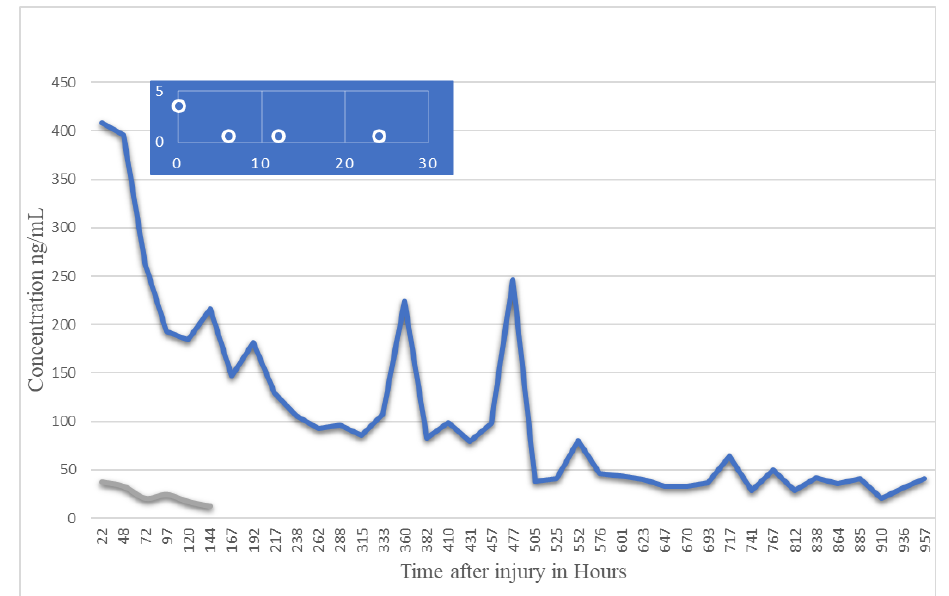
Figure 40. Kinetics of biomarker S100B after the injury data from [119,126,138 – 140].